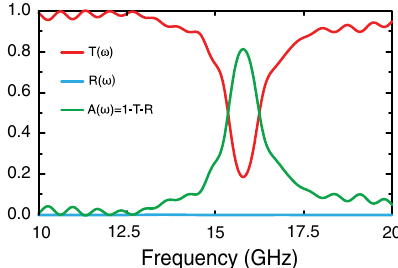
FIG. 5. Experimental results of the reflectivity, transmissivity, and absorptivity of a GHz metamaterial interacting with the SEW carried by a